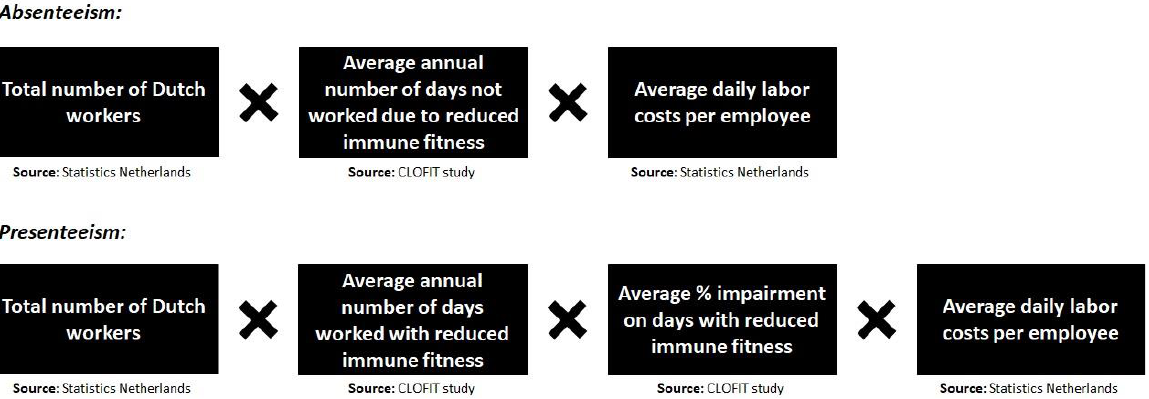
Figure 1. Formulas for calculation the economic costs of absenteeism and presenteeism due to reduced immune fitness.